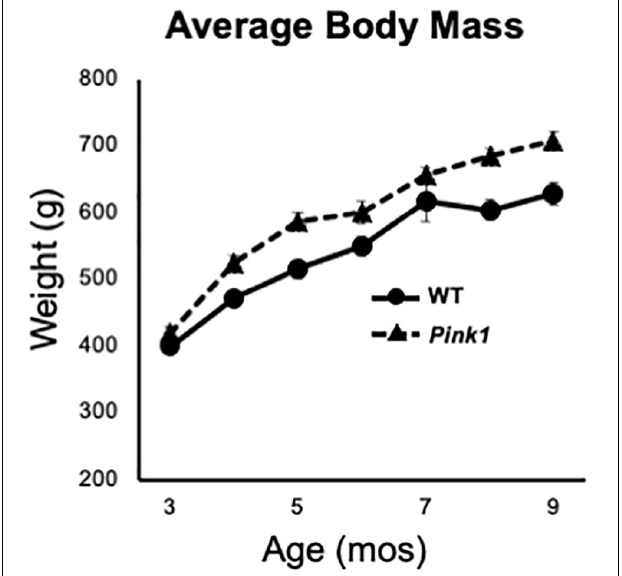
FIGURE 1 | Line graphs showing changes in average weights in grams (g) of the male rats with knockout of the PTEN (phosphatase and tensin homolog)-induced putative kinase1 gene ( Pink1–/–, triangles, dashed line) and the wild type (WT, circles, solid line) control male rats used in this study as they matured from 3 to 9 months (mos) of age. All rats continued to gain weight as the study progressed. As expected, the average weights of Pink1 –/– rats were consistently greater than that of the WT